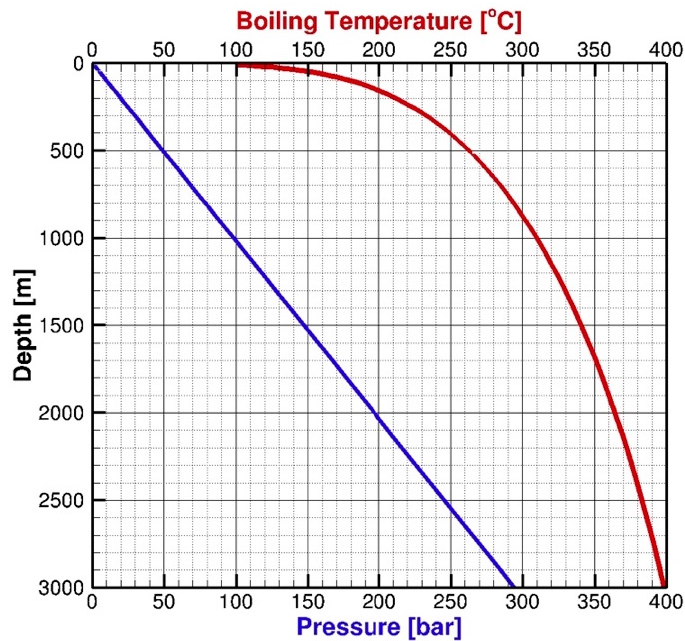
Figure 2. Boiling temperature as a function of pressure and approximate depth, assuming a hydrostatic pressure profile and fully liquid-saturated conditions in the disposal section of the horizontal drillhole.